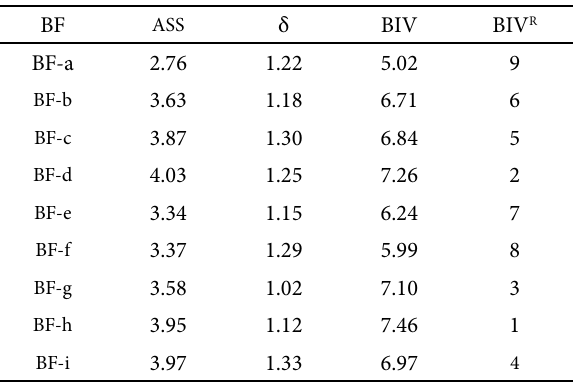
Table 2. Calculated Average Significant Score (ASS) and Beneficial Index Value (BIV) for participant responses to benefits of implementing EMS in the Nigerian construction